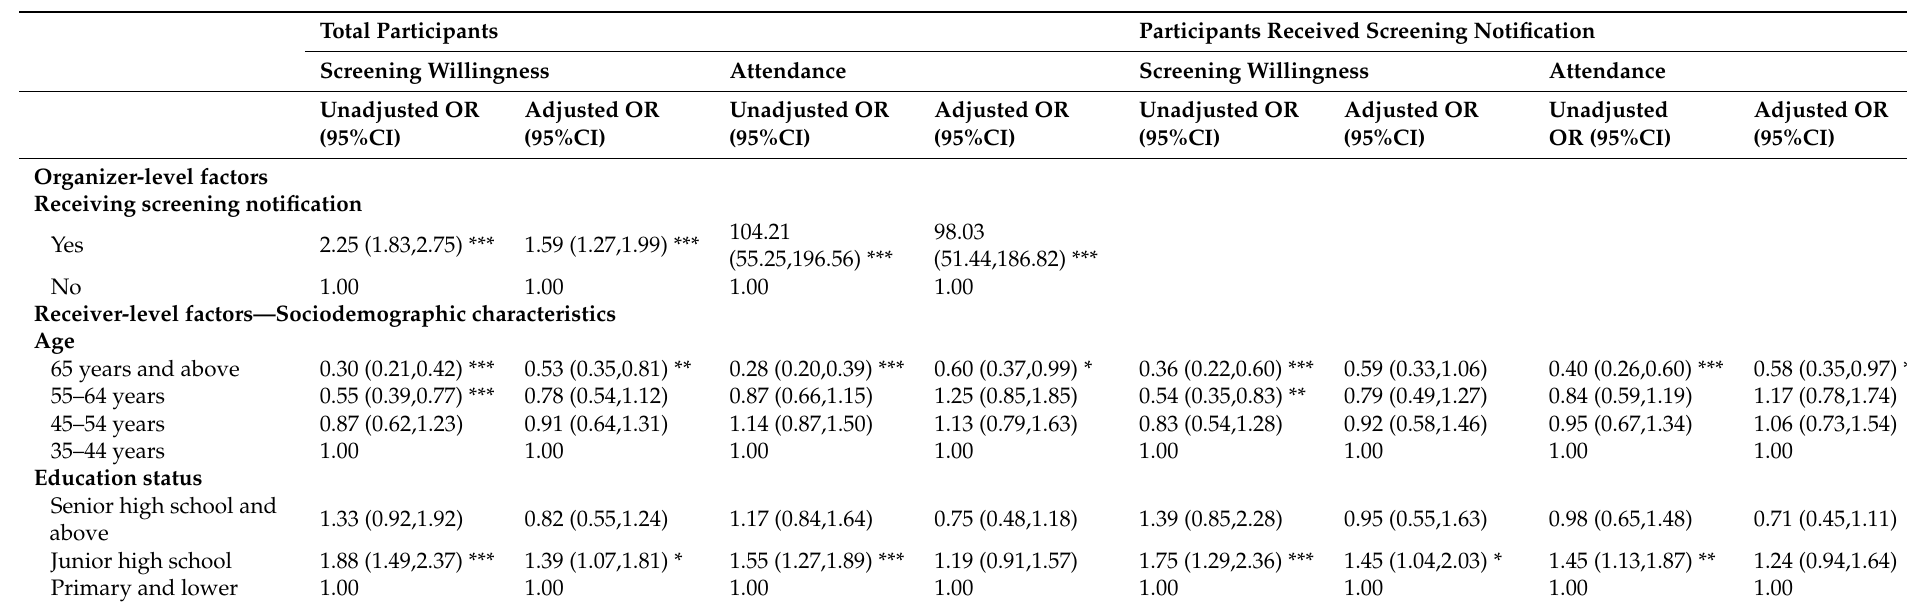
Table 2. Determinants of screening willingness and attendance of breast and cervical cancer screening in rural China